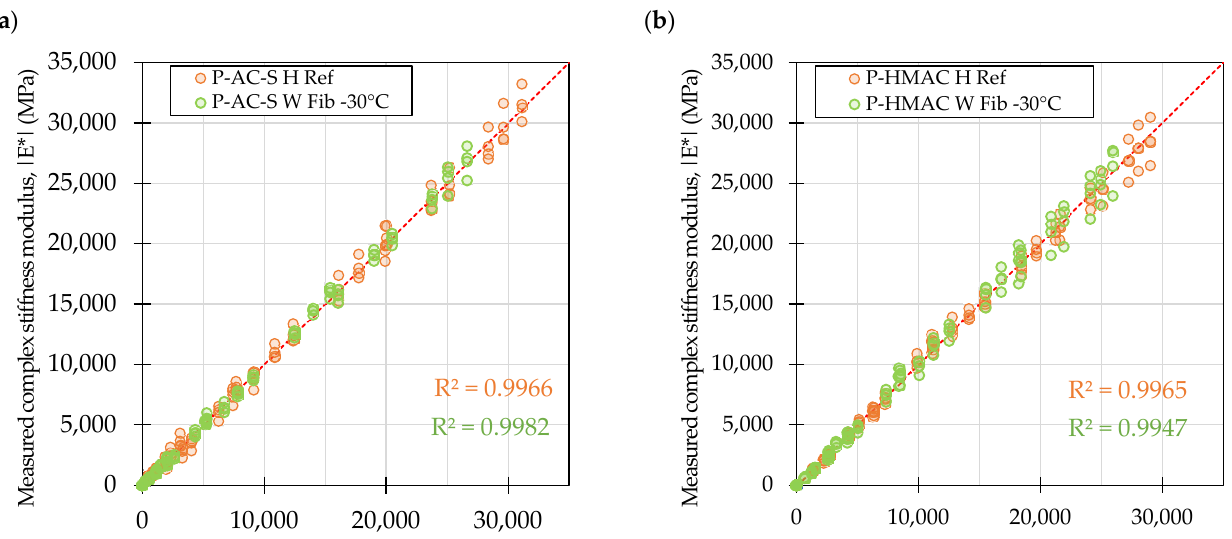
Figure 8. Complex stiffness modulus master curves characterizing the evaluated surface course ( a ) and high modulus asphalt concrete ( b ) mixtures produced in the asphalt plant.